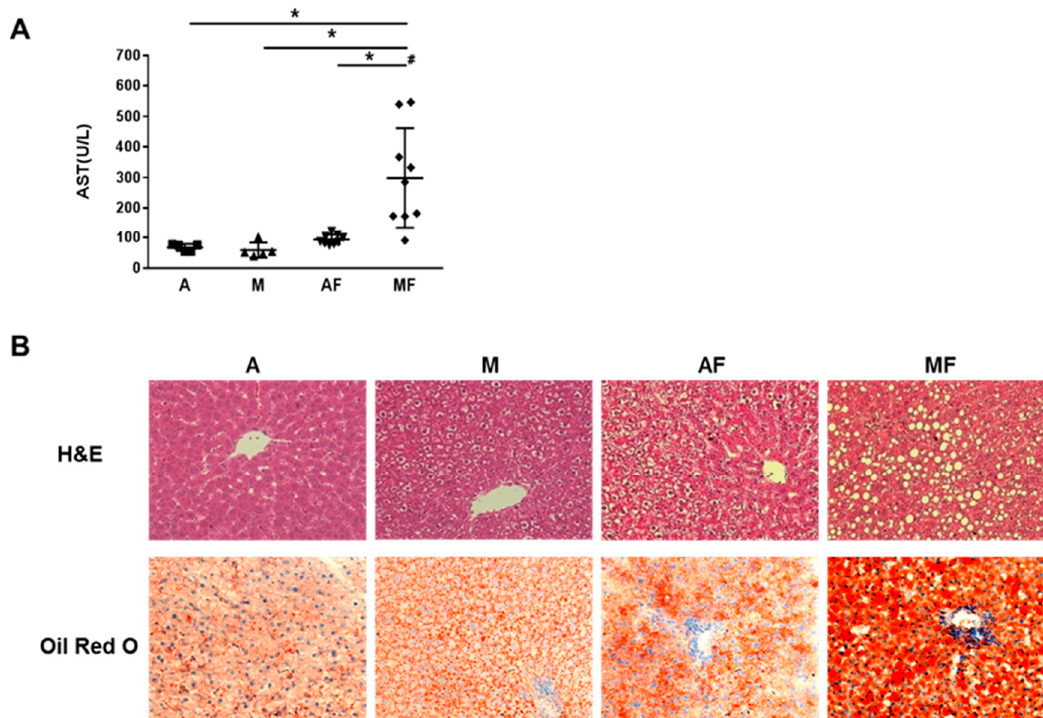
Figure 3. Effects of marginal copper deficiency and fructose feeding on liver injury and lipid accumulation in male weanling Sprague-Dawley rats. ( A ) Plasma AST. ( B ) Representative photomicrographs of the H&E and Oil Red O staining of liver section (200×). Data represent means ±